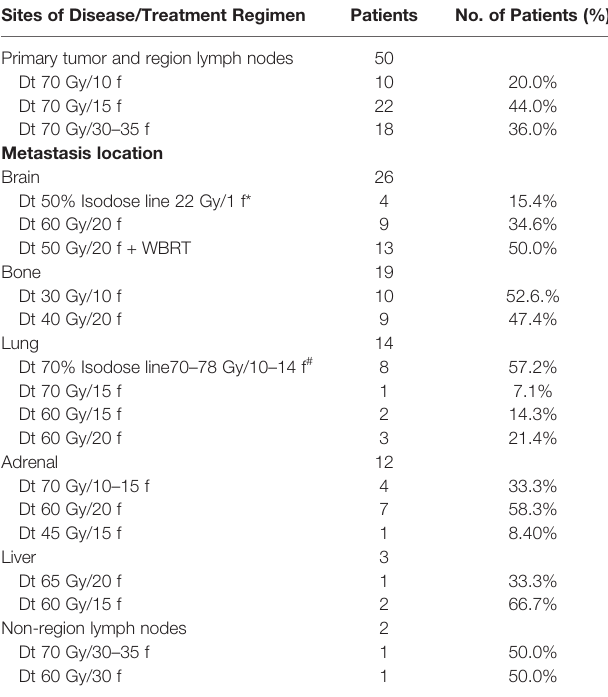
TABLE 3 | Local radiation therapy for primary tumor and oligometastatic sites mode. Sites of Disease/Treatment Regimen